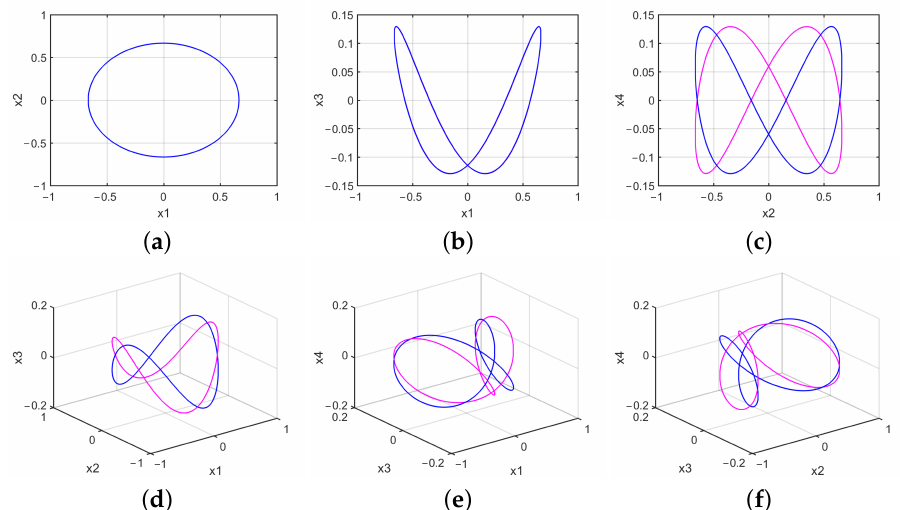
Figure 9. Morphology and relative positions of two periodic solutions when f 1 = f 12 : ( a ) ( x 1 , x 2 ) plane; ( b ) ( x 1 , x 3 ) plane; ( c ) ( x 2 , x 4 ) plane; ( d ) ( x 1 , x 2 , x 3 ) space; ( e ) ( x 1 , x 3 , x 4 ) space; ( f ) ( x 2 , x 3 , x 4 ) space.